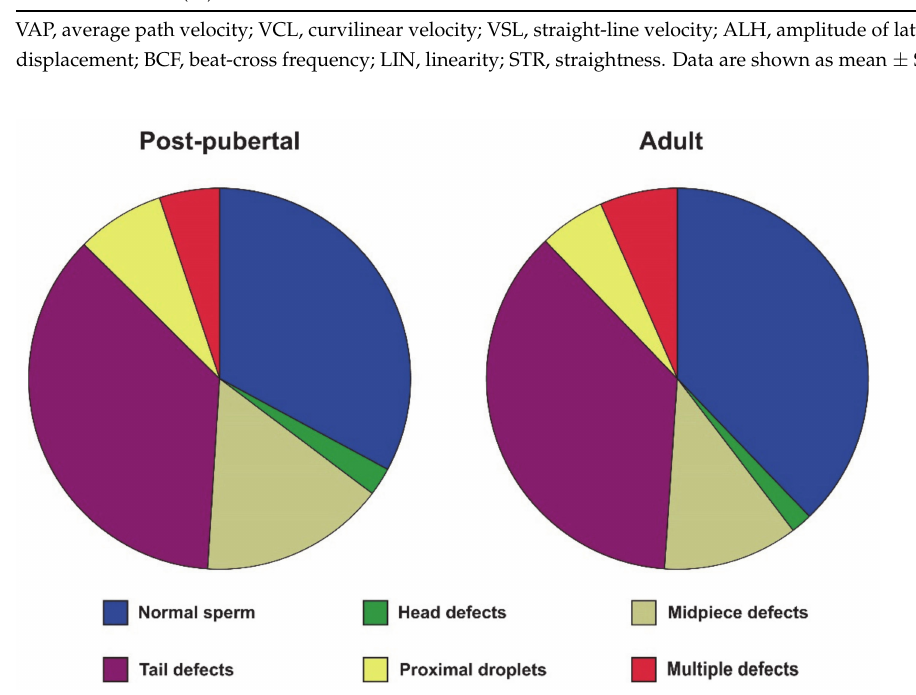
Figure 3. Sperm morphology in <1-year-old (post-pubertal, n = 9) and >1-year-old (adult, n = 7) sexually mature tomcats. No statistically significant differences were found between groups ( p > 0.05). The proportion of each sperm structure in relation to the total sperm length in tomcats (N = 16) was: head length, 8.56%; midpiece length, 13.45%; principal piece length, 70.71%; and terminal piece length 7.29%. In addition, sperm size did not differ between post- pubertal and adult cats ( p > 0.05, Table 5), whereas the intra-male variation in sperm head size did differ between groups ( p < 0.05, Table 6). Interestingly, adult cats showed a lower intra-male coefficient of variation (CV) in sperm head width and ellipticity than post-pubertal adult cats ( p < 0.05, Table